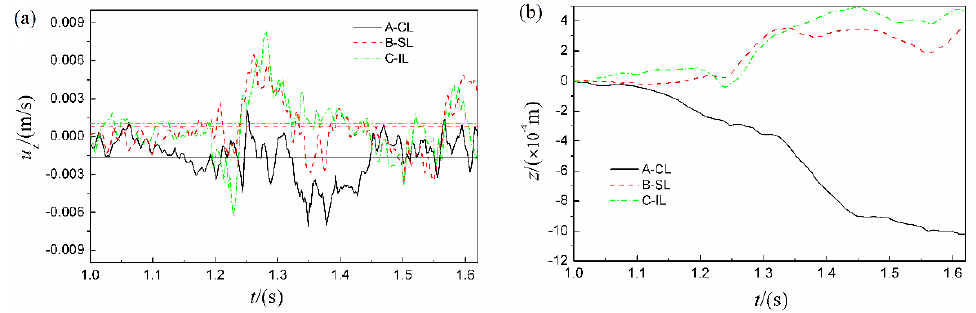
Figure 11. Effects of Cr on particle sedimentation velocity ( a ) and displacement ( b ).